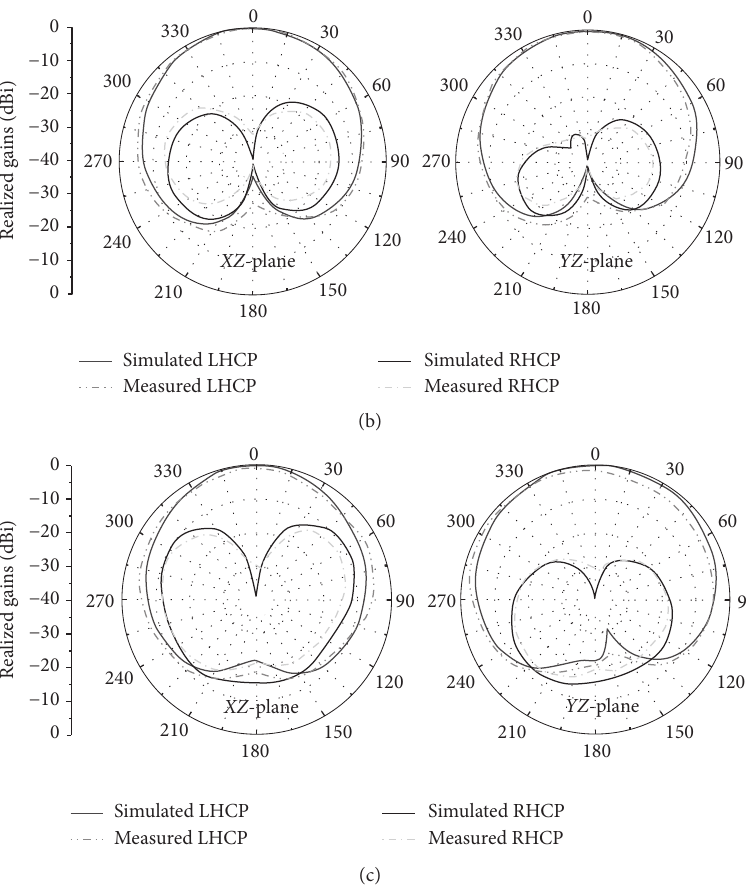
Figure 8: Simulated and tested normalized radiation patterns of the designed antenna at (a) 2.18, (b) 2.72 GHz, and (c)